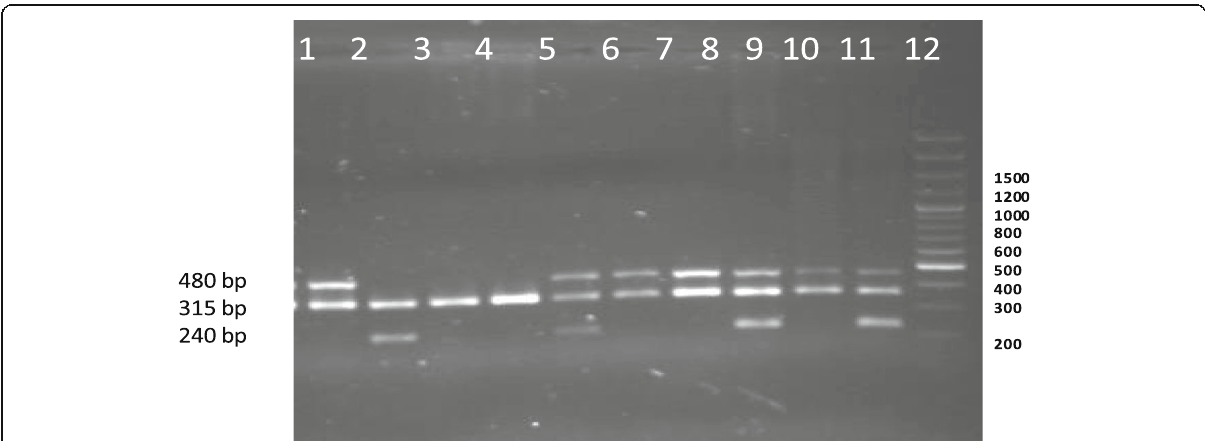
Fig. 1 A multiplex-PCR analysis of GSTM1 and GSTT1 gene polymorphism. GSTM1 and GSTT1 PCR products were analyzed directly by electrophoresis on a 1% agaros gel. GSTT1(480 bp), GSTM1(240bp) and Albumin (315 bp) genes. Lane 3,4 GSM1-null/GSTT1-null, Lane 1,6,7,10